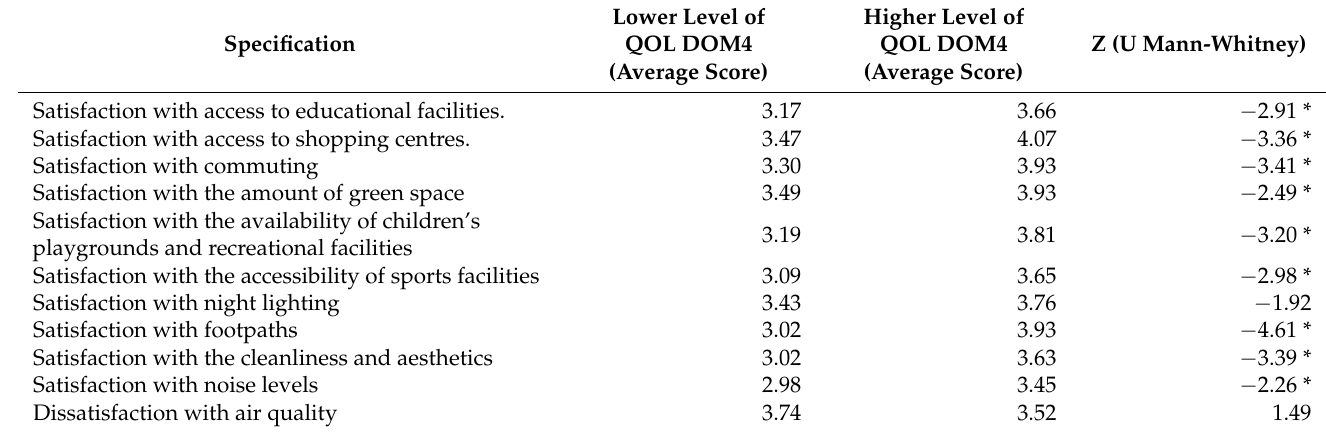
Table 6. Comparison of satisfaction with selected elements of urban infrastructure by level of quality of life in the environmental domain (DOM4) (Mann-Whitney U test).